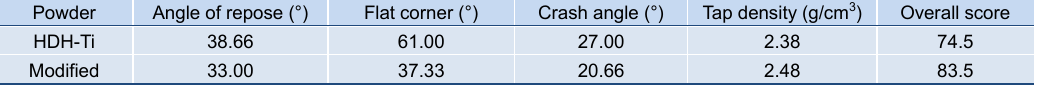
Fig. 1 | SEM images of the various HDH-Ti powders modified by the ball milling processing using different parameters. Table 3 | Powder flowability results of the modified and unmodified HDH Ti powders.